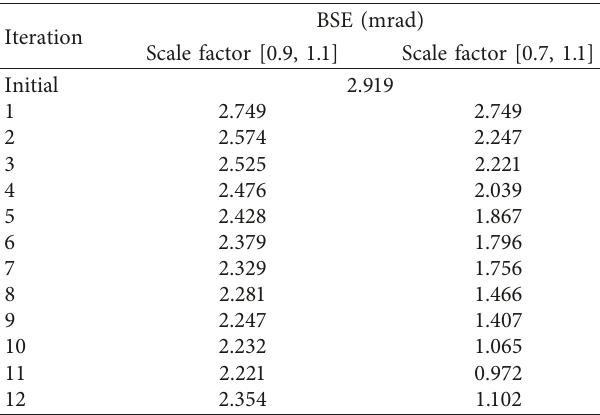
Table 4: The maximum BSE during IPD correction iteration without incident angle modification factor.